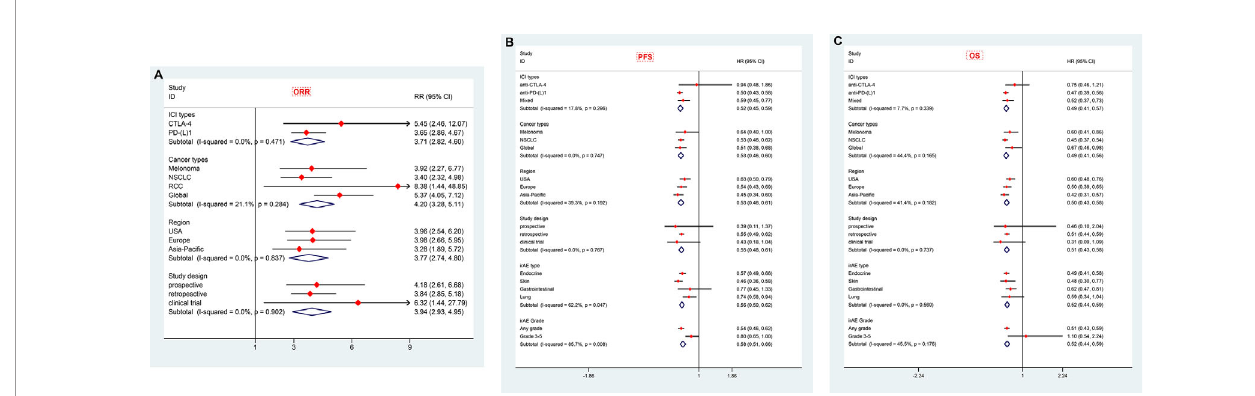
FIGURE 6 | Summary of subgroup analyses in exploring associations of immune-related adverse events with ORR (A) , PFS (B) and OS (C) in cancer patients strati fi ed by cancer types, ICIs types, organ-speci fi c-irAEs, geographical regions and study designs. ICIs, immune checkpoint inhibitors; CTLA-4, cytotoxic T- lymphocyte antigen 4; PD-(L)1, programmed cell death (ligand) 1; NSCLC, non-small cell lung cancer; RCC, renal cell carcinoma; irAEs: immune-related adverse events; ORR, objective response rate; PFS, progression free survival; OS, overall survival; RR, risk ratio; HR, hazard ratio; CI, con fi dence